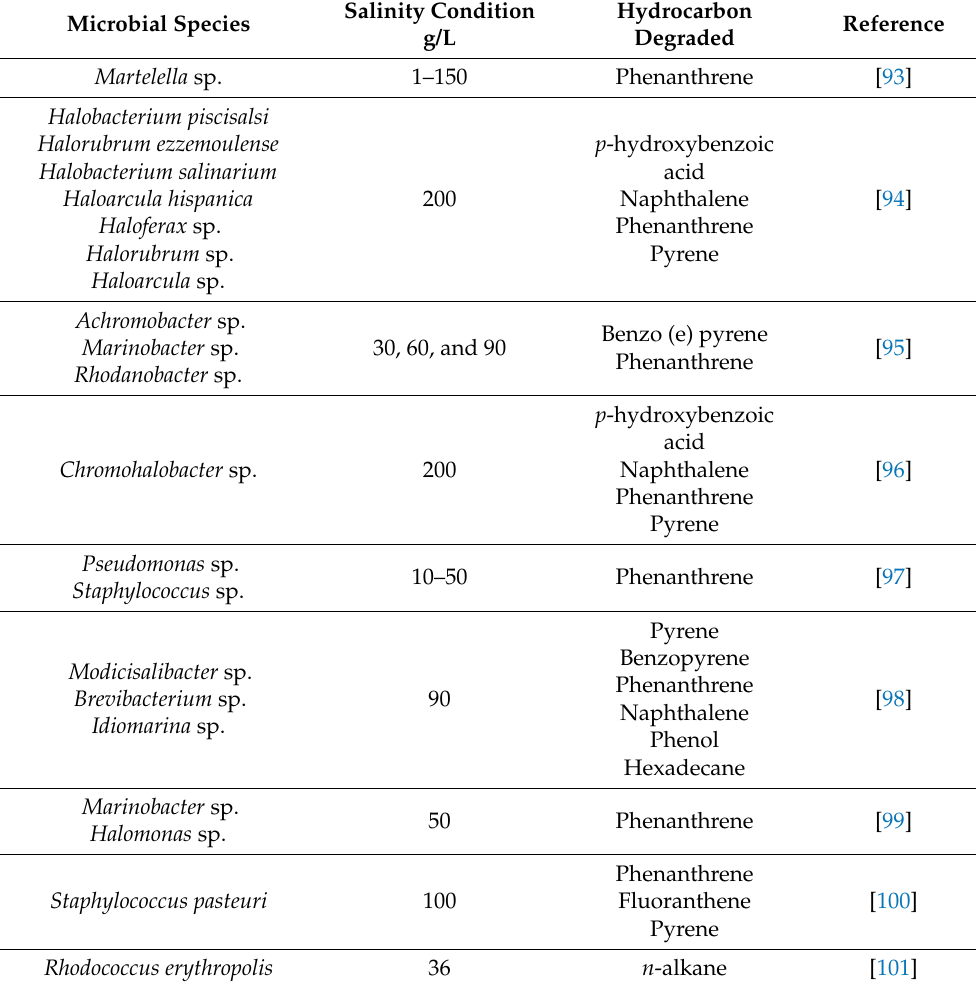
Table 5. List of halophilic microorganisms and the hydrocarbon degraded. Microbial